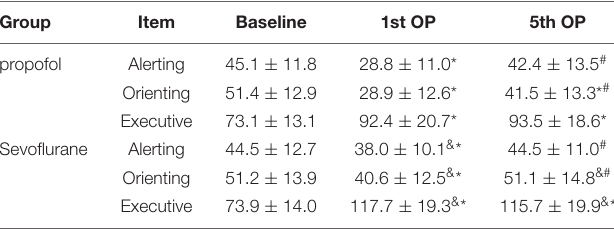
TABLE 3 | Differences at baseline and the 1st and 5th OP sessions between the alerting, orienting and executive networks. Group